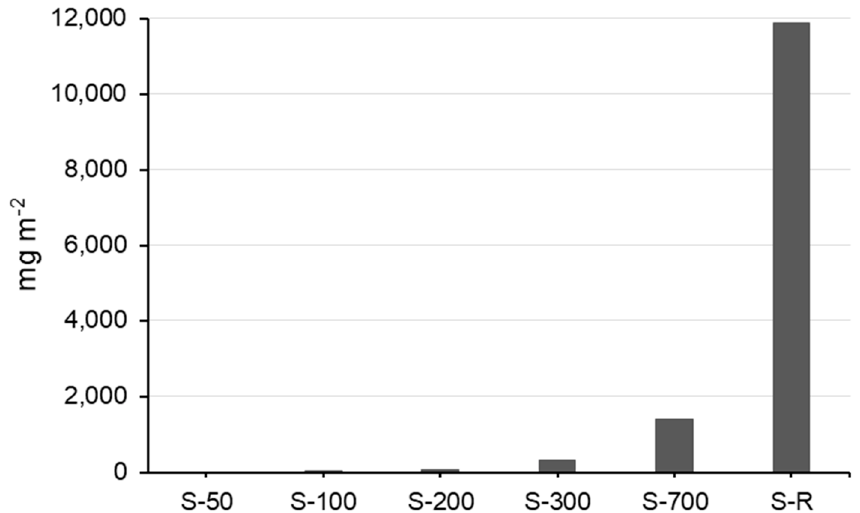
Figure 3. Potential ecological risk index of single ( E (cid:2928)(cid:2919) ) and total (PERI) HMs in the soil located at different distances from the Alaverdi copper smelter.